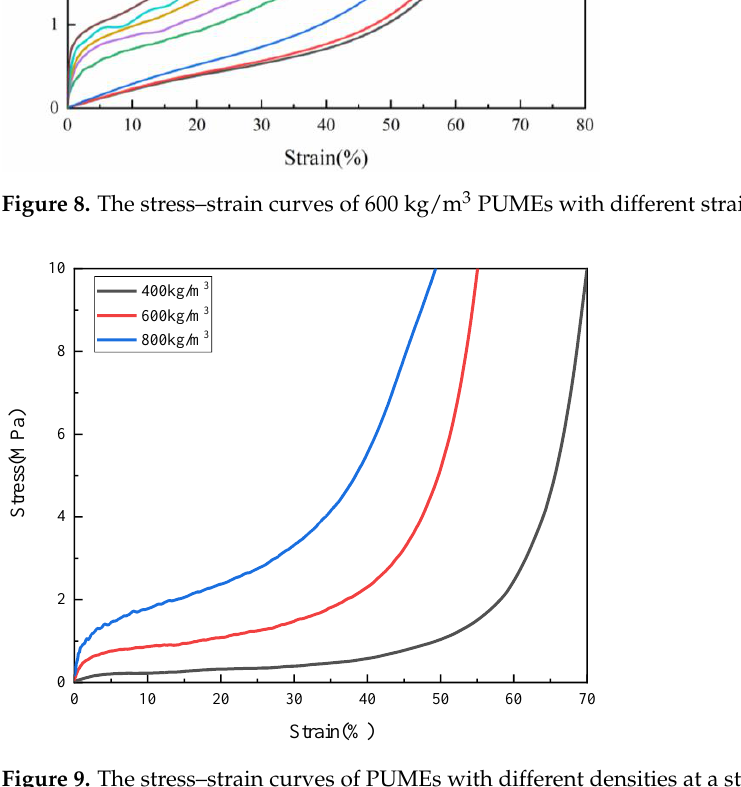
Figure 9. The stress–strain curves of PUMEs with different densities at a strain rate of 2300 s −1 and test temperature of 23 °C ± 2 °C.